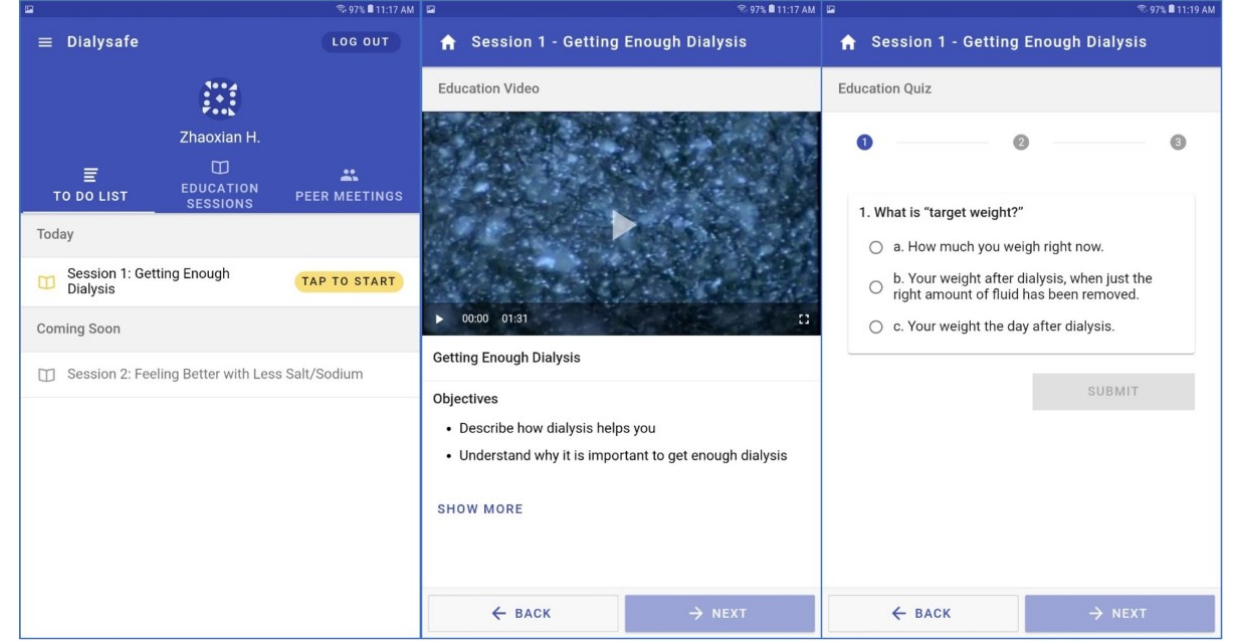
Figure 1. Screenshots from the tablet-based intervention: homepage showing the main to-do list (left panel), a typical educational model presenting content on intradialytic hypotension prevention with learning objectives (middle panel), and a quiz that is delivered after each session (right